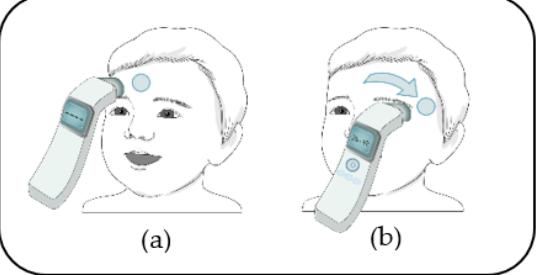
Figure 1. Measurement using the NCFIT. ( a ) The sensing area of the NCFIT was positioned at a distance of 2–3 cm from the center of the forehead at a right angle, and then the measurement button was pushed. ( b ) The scan was performed slowly toward the left temple for 3–4 s with the button being pushed until the measurement completion sound was obtained. The temperature was displayed on the screen once the measurement was